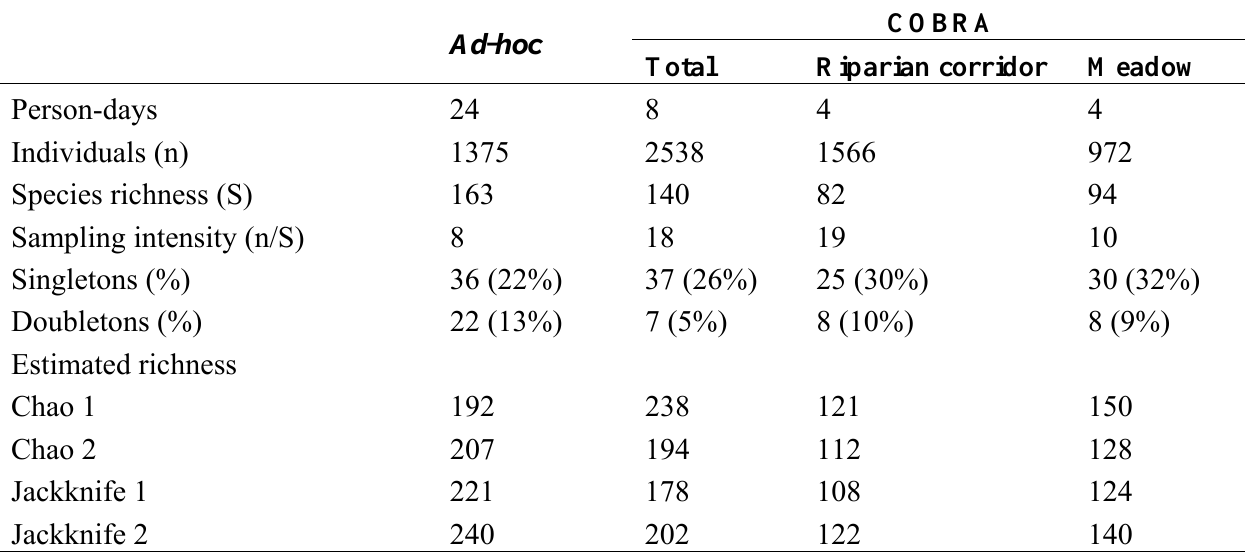
Table 1. Overall results for the different sampling approaches and